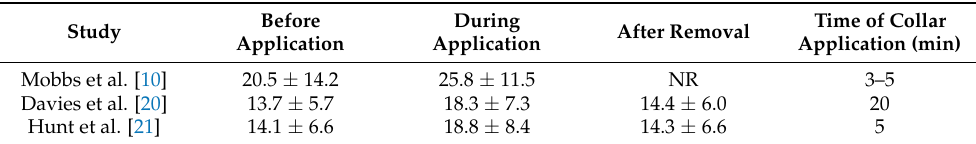
Table 4. ICP measurements (mean ± SD/mmHg) before, during, and after the application of cervical collars from studies identified by the systematic search.